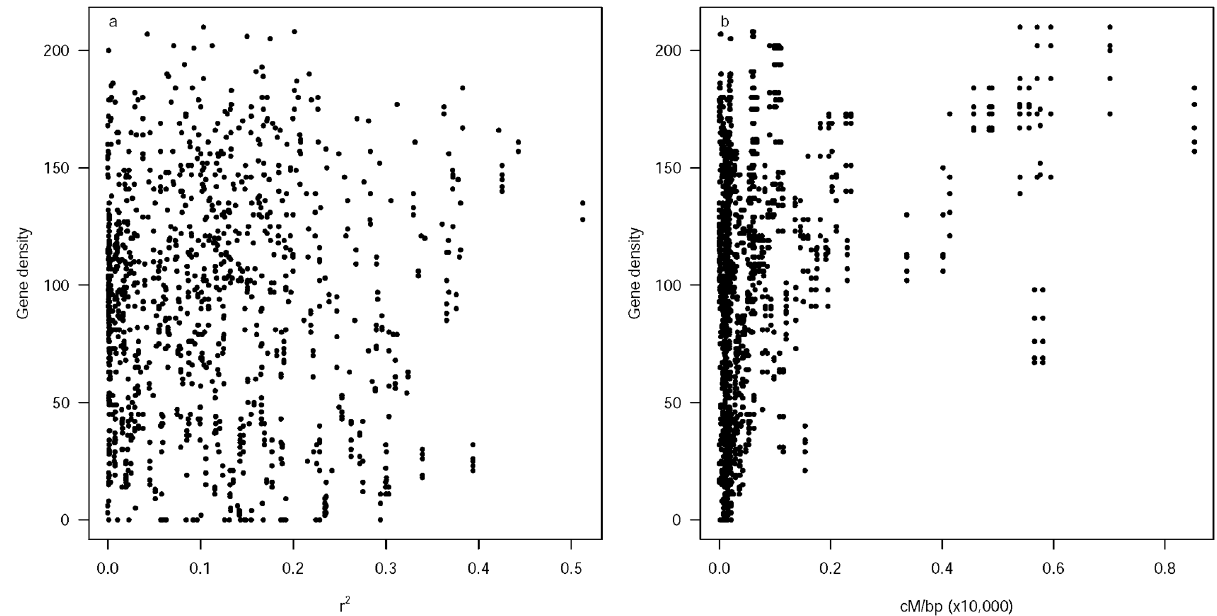
Fig 7. Relationship between gene density and linkage disequilibrium and recombination rate, respectively, measured as r 2 (a) and genetic to physical distance ratio in cM/bp x 1,000 (b). Both analyses based on sliding window analysis comparing number of genes in a 1 Mb window at 200 Kb interval walk speed throughout the